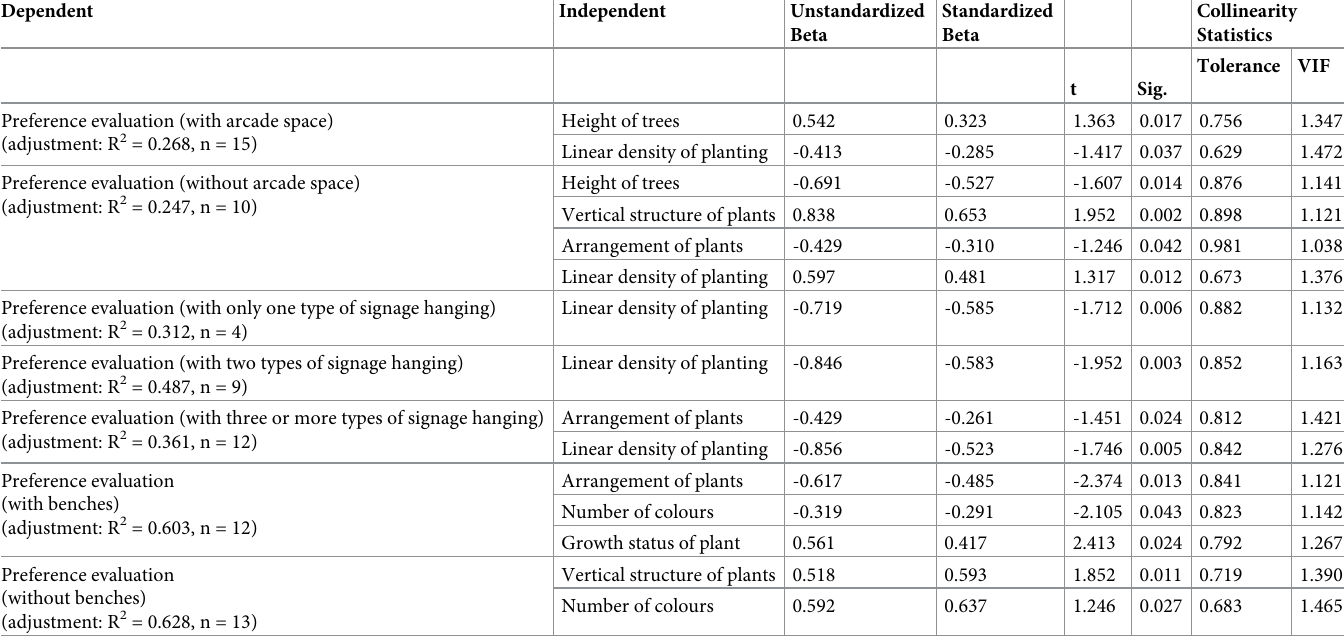
Table 5. Analysis of the relationship between plant characteristics and outdoor spatial characteristics.